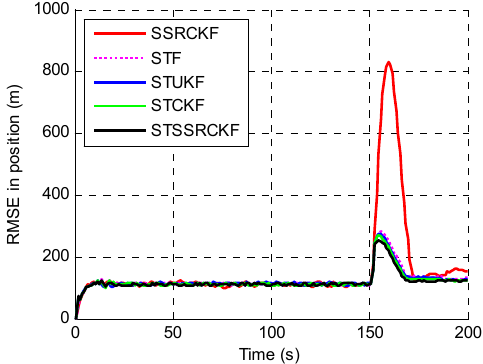
Figure 1. Root mean square error (RMSE) of the estimated position.